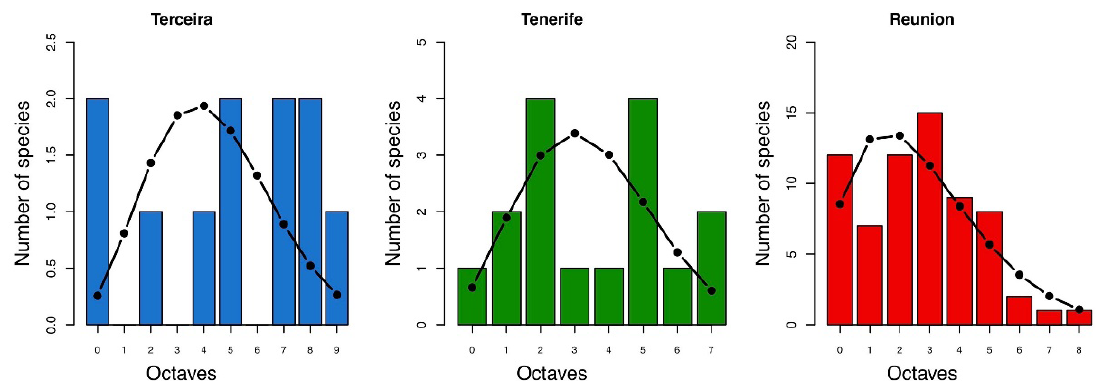
Figure 2. Species abundance distribution (SADs) histograms for woody plants in Terceira (a), Tenerife (b), and Reunion (c). The following binning system was used: 0 corresponds to the number of species with 1 individual per species, bin 1 corresponds to the number of species with 2-3 individuals per species, bin 2 corresponds to the number of species with 4-7 individuals per species, etc. The curve represents the best fit model (Gambin).